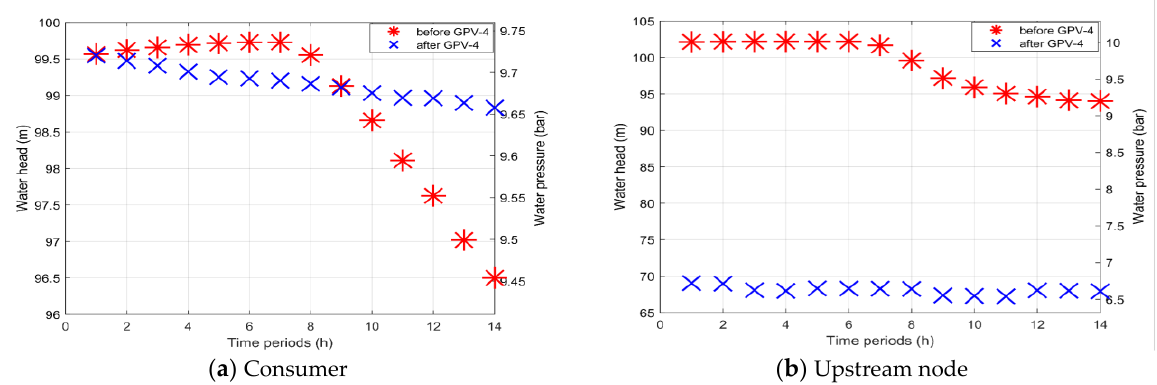
Figure 16. Turbine mechanical power output, efficiency, and rotational speed for each active time period.